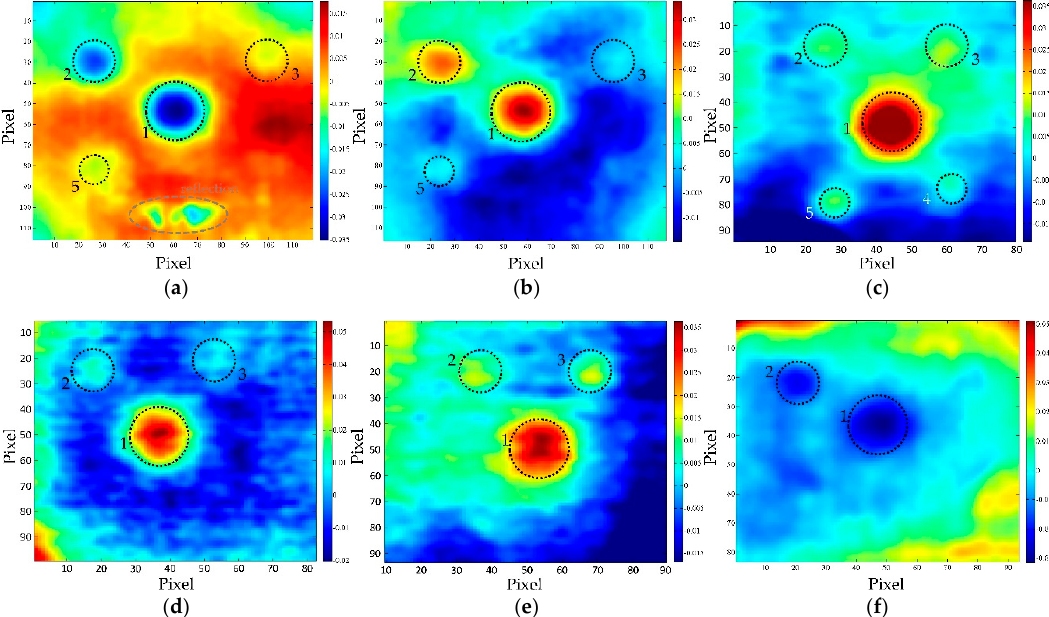
Figure 12. PCT, BM 2-2 distance 2m, top side: ( a ) heating & cooling sequence, (EOF 2 ); ( b ) heating sequence (EOF 3 ); ( c ) cooling sequence, (EOF 2 ). Table 7. SNR values obtained from images presented in Figure 12.